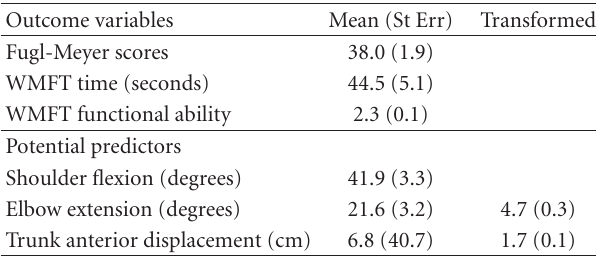
Table 2: Descriptive statistics ( n =